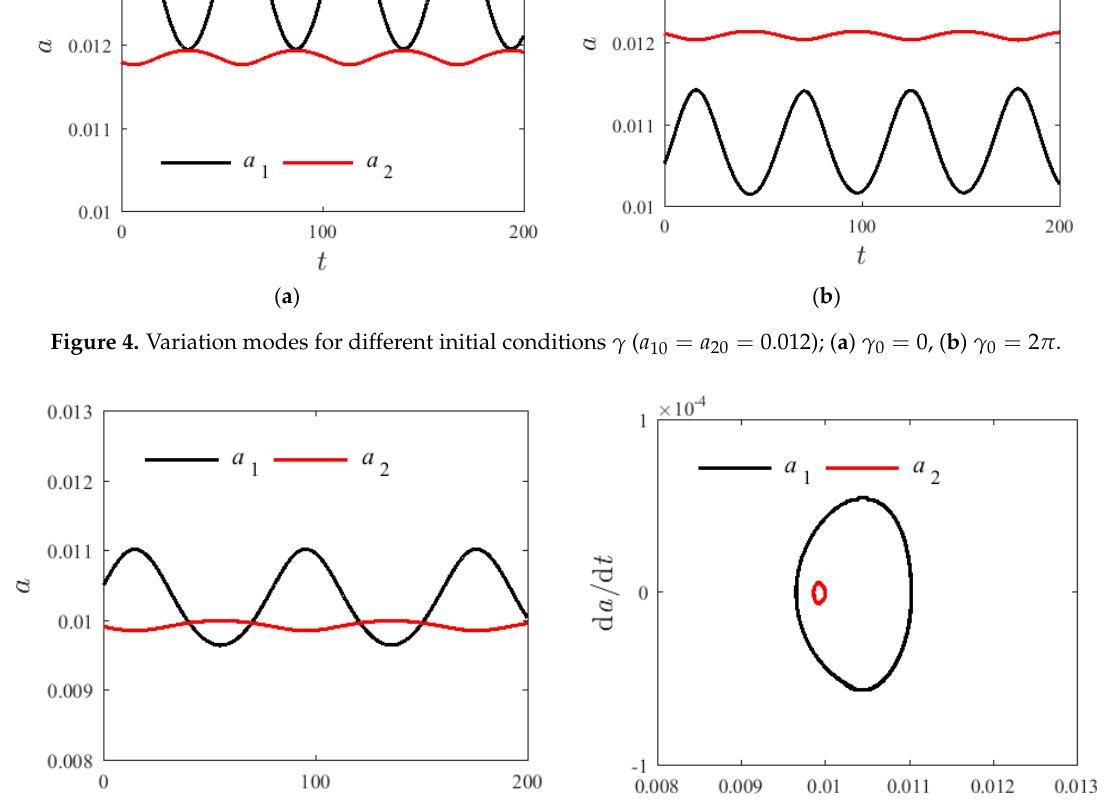
Figure 4. Variation modes for different initial conditions γ (